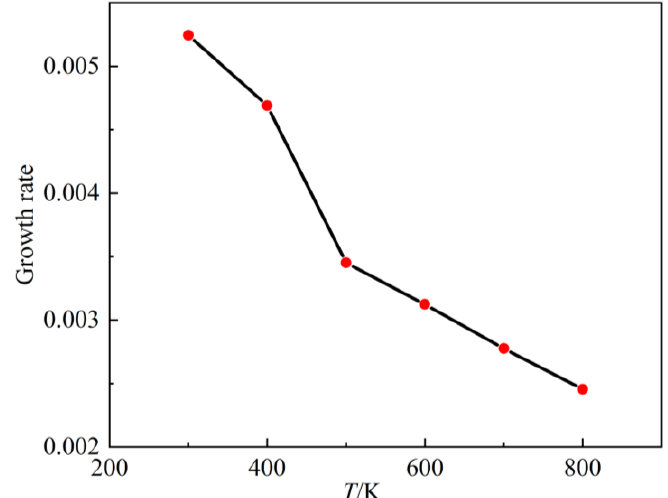
Figure 19. Growth rate curve with environment; temperature increases from 300 K to 800 K.